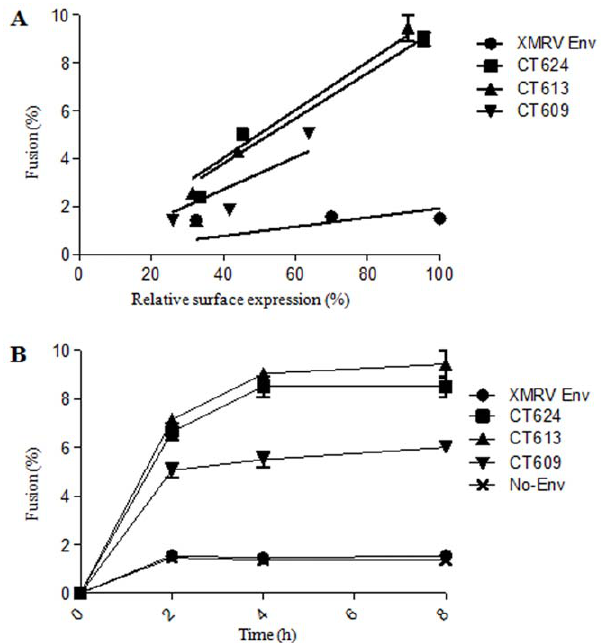
Figure 5. Truncation beyond the putative R-peptide cleavage site does not further enhance the XMRV Env fusion activity. (A) Effect of Env expression on cell-cell fusion. Effector 293T/GFP cells were transfected with different amounts of plasmids encoding indicated XMRV Env, and co-cultured with target CMTMR-labeled 293 cells. Fusion percentages were determined by flow cytometry following 6 h incubation. In parallel, the XMRV Env surface expression was measured by flow cytometry using an anti-FLAG antibody. The obtained fusion percentages were plotted against Env surface expression. A represen- tative experiment with standard errors of triplicate samples is shown (n=3). (B) Effect of incubation time on cell-cell fusion. Effector 293T/GFP cells expressing indicated XMRV Env were co-cultured with target CMTMR-labeled 293 cells and cell-cell fusion was assessed after different periods of incubation time. A representative experiment with standard errors of triplicate sample is shown (n=3). doi:10.1371/journal.pone.0033734.g005 retroviral vector encoding XPR1 [33]. Expression of XPR1 in the CHO/XPR1 cell line was demonstrated by the specific binding of soluble XMRV SU fusion protein to those cells as shown in Figure 2B, and was further confirmed by immunostaining using an anti-XPR1 antibody (Fig. 6A). The titers of XMRV wildtype and CT truncation mutants in these two cell lines are shown in Table 1.